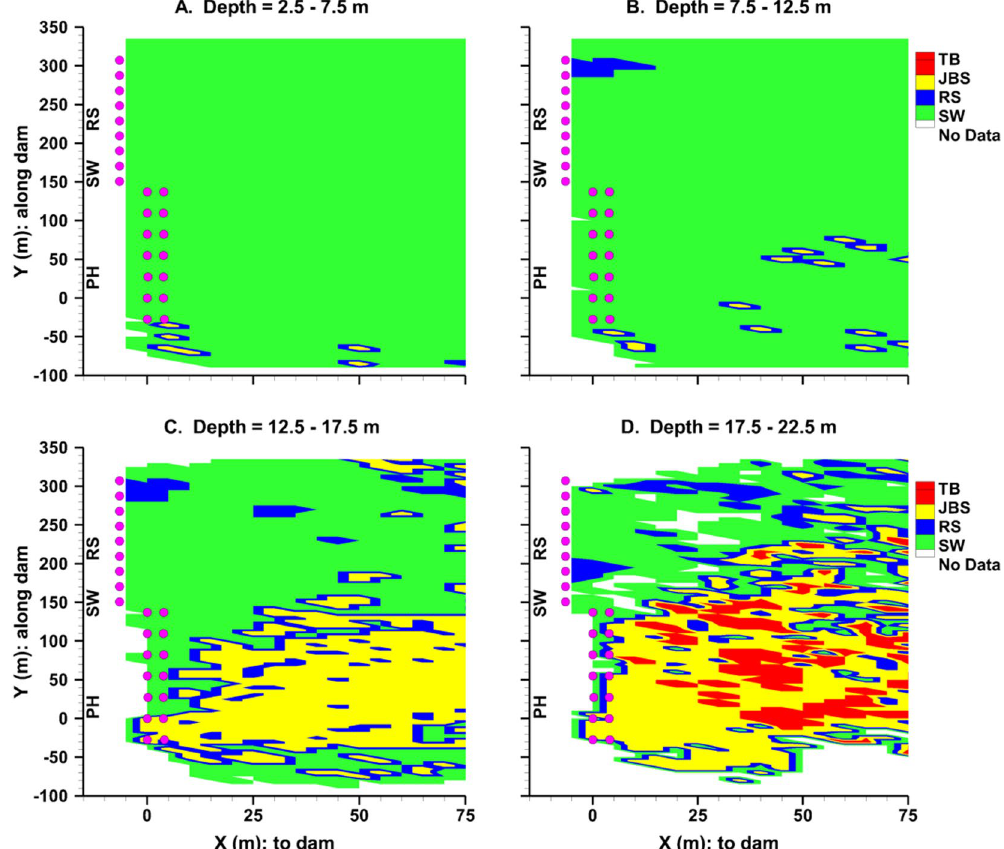
Figure 3. Distribution of highest passage probability for subyearling Chinook passed by four different routes (“TB” = turbine; “JBS” = juvenile bypass system; “RS” = regular spillway; “SW” = spillway weir) at LGS during 2013 summer at four different depth levels. ( A ) Depth = 2.5 to 7.5 m; ( B ) Depth = 7.5 to 12.5 m; ( C ) Depth = 12.5 to 17.5 m; ( D ) Depth = 17.5 to 22.5 m. Solid purple dots are locations of hydrophones at piers showing the location of the dam face. “PH” indicates the powerhouse section. The highest probability among passage routes was represented by the corresponding color.